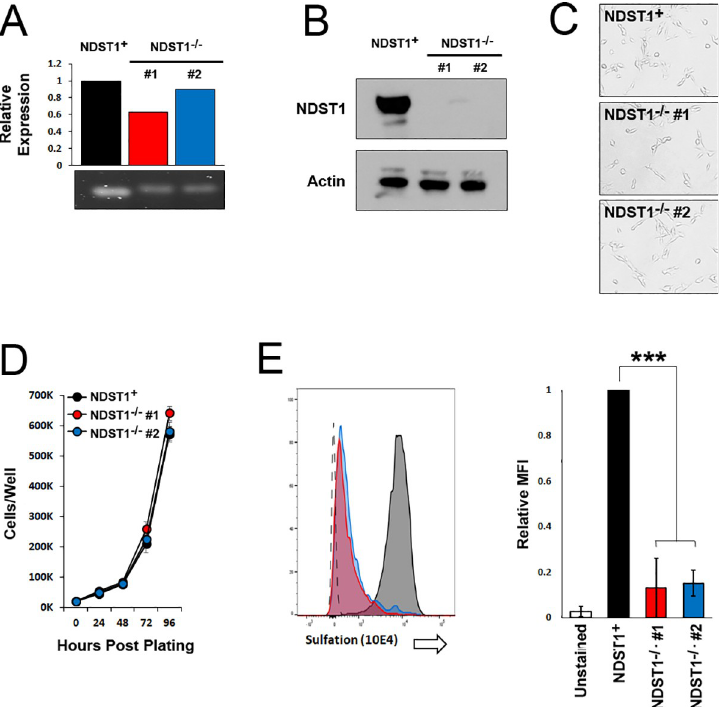
Fig 1. Generation of cells deficient in sulfation of cell surface heparin chains. (A) PCR analysis of NDST1 mRNA expression in NDST1 + and NDST1 deficient cell lines. Bar graph shows quantitative data from real-time PCR analysis. Qualitative agarose gel is shown for visual purposes. (B) Western Blot analysis was performed using the indicated antibodies to detect expression of NDST1. Expression of actin is shown as a loading control. Data is representative of two independent experiments. (C) Phase contrast images of NDST1 + and deficient cells depicting general overall cellular morphology. (D) Cell growth of both NDST1 + and deficient cells measured over a 96-hour period. Data is representative of two independent experiments. (E) Sulfation of cell surface heparin measured via flow cytometry utilizing an antibody that recognizes the sulfated 10E4 epitope on HS chains. The mean fluorescent intensity (MFI) values were then normalized to NDST + values to show the relative change in the NDST -/- cell lines. Data is representative of three independent experiments. Statistical significance was determined using Students T-Test. ��� = p <